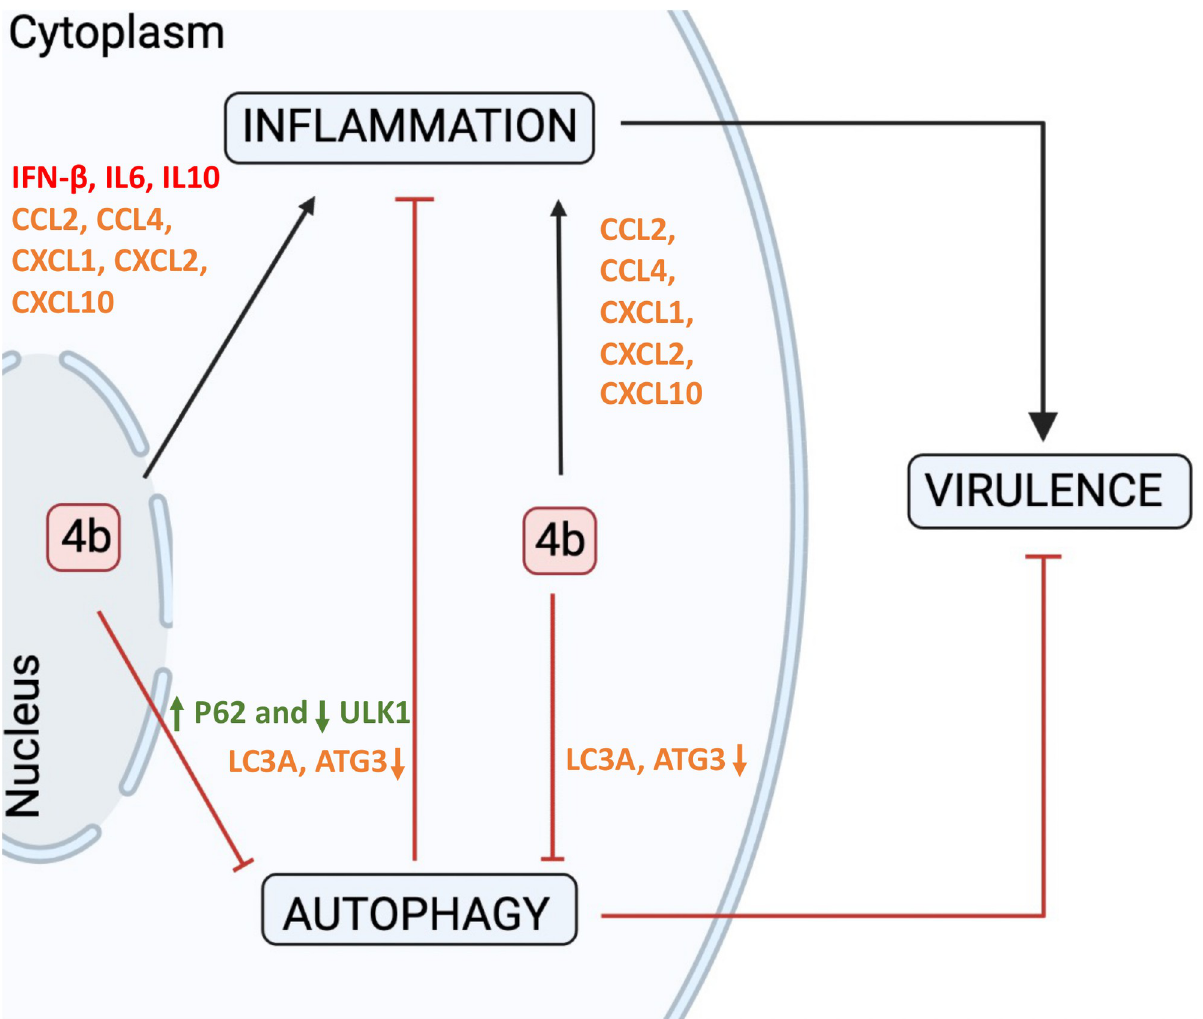
Fig 7. Proposed mechanism of action of 4b protein in MERS-CoV virulence. During MERS-CoV-WT infection, 4b protein accumulates in the nucleus, while in the absence of a functional nuclear localization signal (mNLS), 4b protein is retained in the cytoplasm. The presence of either nuclear or cytoplasmatic 4b is associated with activation of inflammation and inhibition of autophagy, which contribute to virulence in vivo, as shown for MERS-CoV- WT and MERS-CoV-mNLS in a mouse model of infection. According to this work, autophagy contributes to limit inflammation. In the absence of 4b protein, autophagy was activated and a lower inflammatory response was induced, which contributes to attenuation. Chemokine mRNAs increased both in MERS-CoV-WT and MERS-CoV-mNLS infection are indicated in orange. Cytokines mRNA differentially induced in MERS-CoV-WT infection are shown in red. Changes in protein levels are indicated in